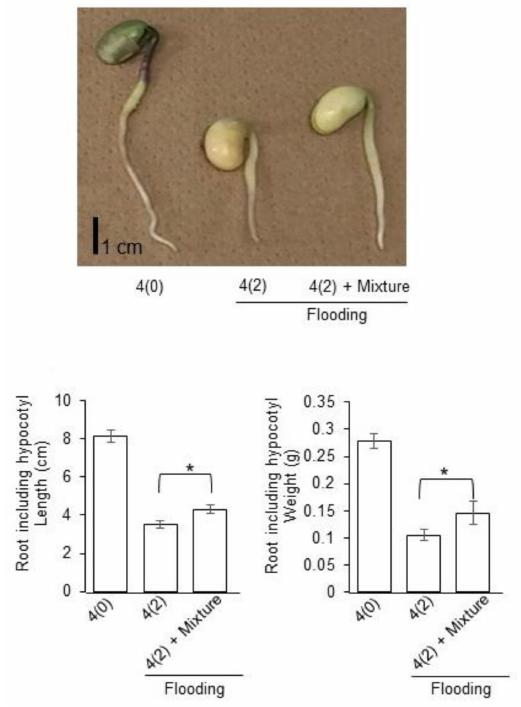
Figure 6. E ff ects of flooding stress with silver NPs / nicotinic acid / KNO 3 on the morphology of soybean seedlings. Two-day-old soybeans were flooded with or without 5 ppm silver NPs / 8 µ M nicotinic acid / 0.1mM KNO 3 . After treatments, length and weight of root including hypocotyl were measured at two days of stress. Data are presented as the mean ± S.D. from three independent biological replicates. Significance was calculated using Student’s t test (* p < 0.05). Scale bar indicates 1